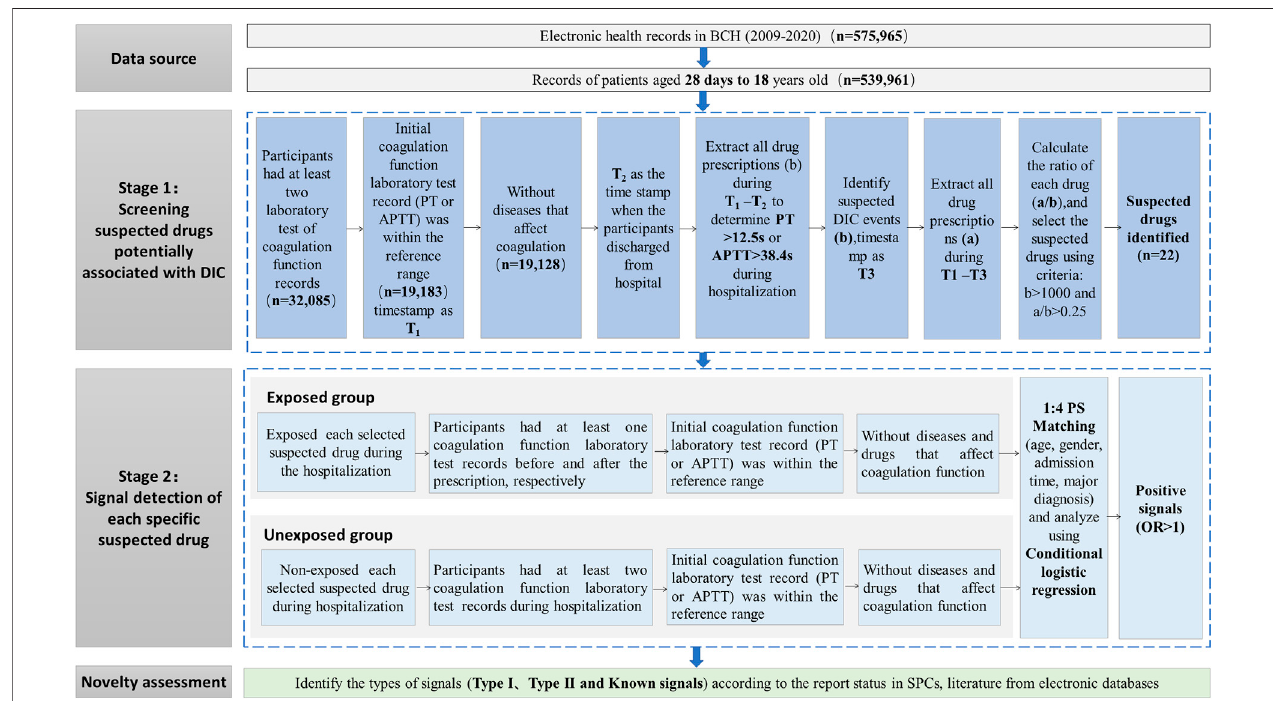
FIGURE 1 | Work fl ow of the signal detection method of DIC using EMR data. Abbreviations: APTT, activated partial thromboplastin time; DIC, drug-induced coagulopathy; EMR, electronic medical records; PT, prothrombin time.